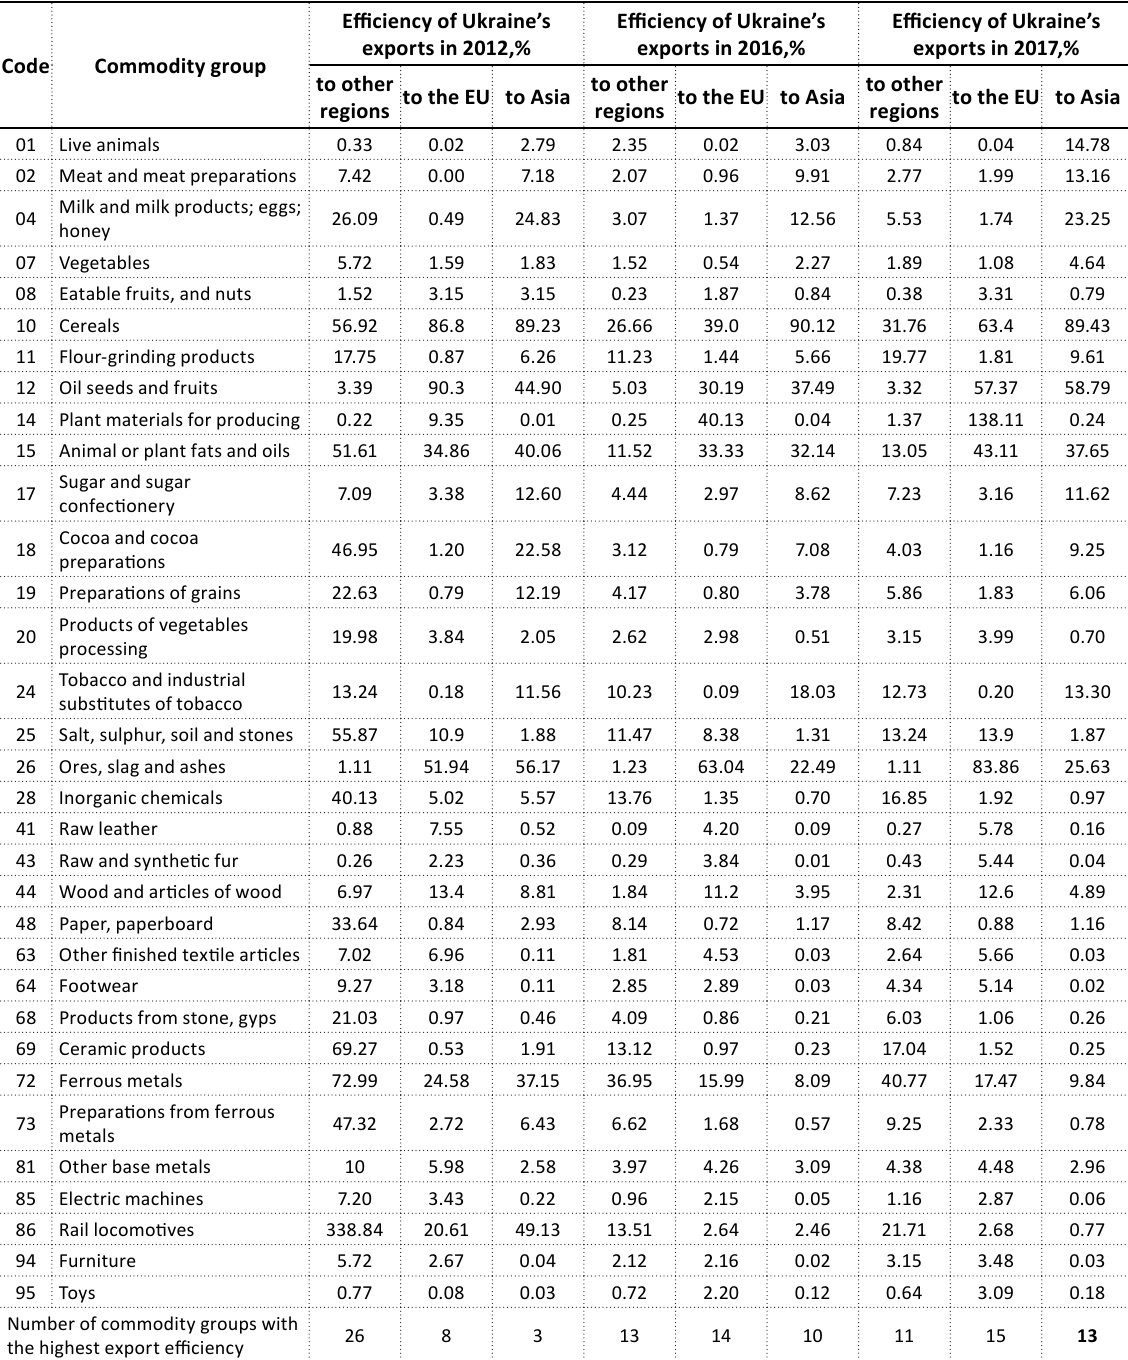
Table 7. Comparative analysis of export efficiency of certain commodity groups of Ukraine in the EU, Asia and other regions of the world in 2012–2017 Source: Calculated by the authors. Efficiency of Ukraine’s Efficiency of Ukraine’s exports in 2012,% exports in Code Commodity group